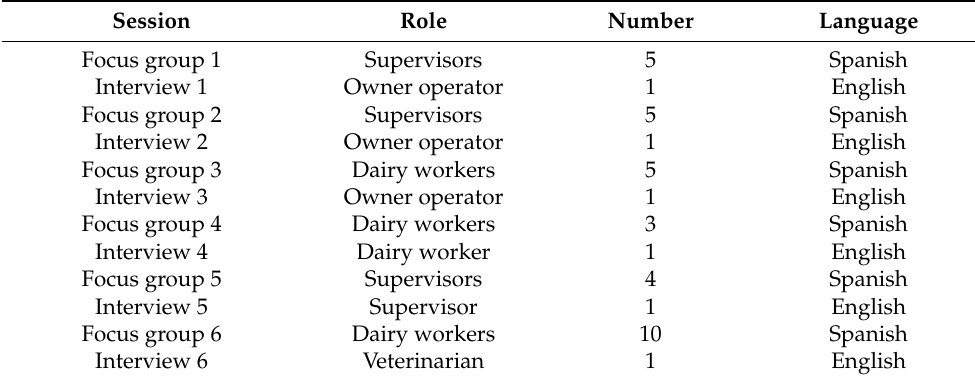
Table 1. Participant role, number, and language by focus group or interview